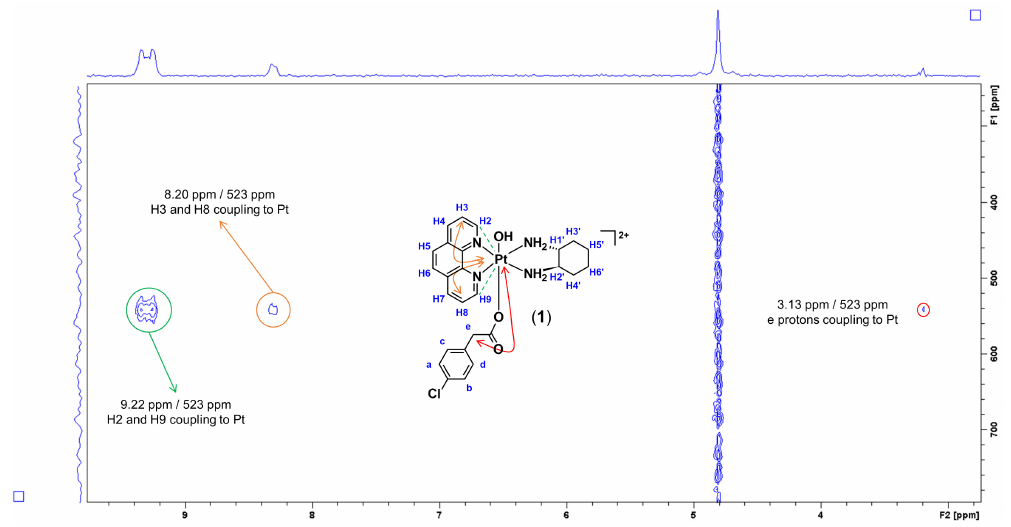
Figure 11. Expanded 1 H − 195 Pt-HMQC spectrum of 1 in D 2 O, obtained at 298 K highlighting the coupling between protons and the platinum centre. Inset: structure of 1 with proton labelling system.